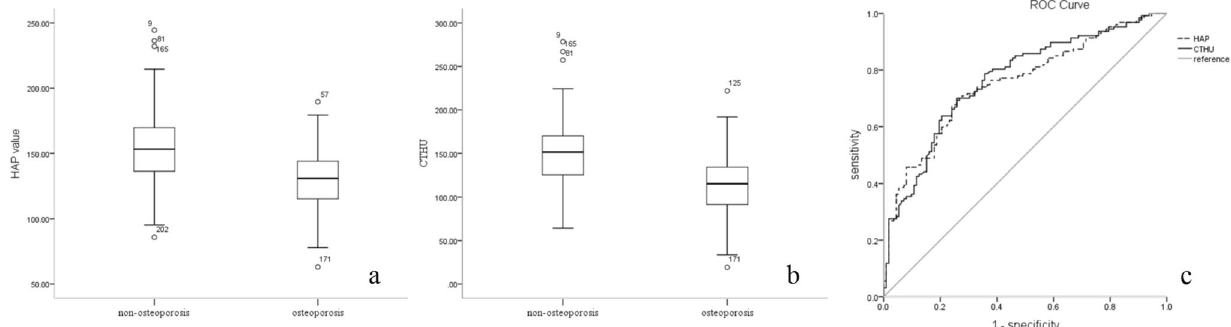
Figure 2. Diagnosing osteoporosis by using HAP concentration and CT value. Box chart. There was significant difference between the osteoporosis group and non-osteoporosis group ( a ): HAP concentration; ( b ): CT value. ( c ): ROC of using HAP concentration (dotted line) and Hounsfield unit (HU) measurements (solid line) for the detection of osteoporosis. The area-under-the-curve (AUC) using HAP and CT value was 0.754 and 0.766, respectively for diagnosing